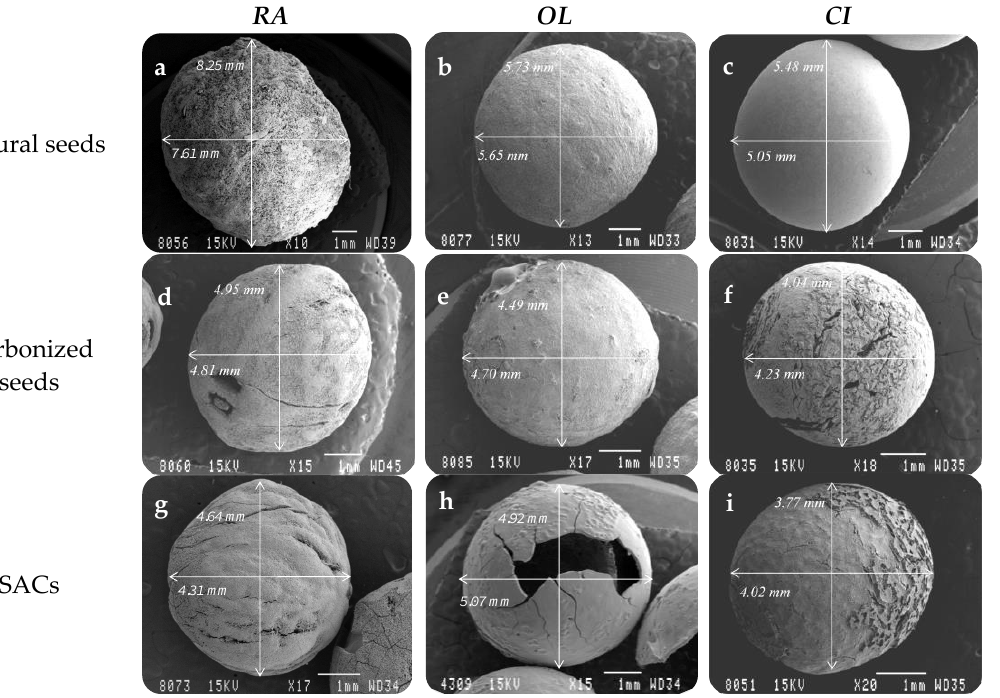
Figure 3. SEM images of precursors, carbonized materials and final SACs. Experimental preparation conditions of the materials: ( a – c ) dried at 110 °C for 3 h; ( d – f ) carbonized at 850 °C for 2 h in 300 mL/min N 2 flow; ( g ) activated at 800 °C for 30 h using 80 mL/min CO 2 flow; ( h ) activated at 800 °C for 2 h in 80 mL/min CO 2 flow; ( i ) activated at 800 °C for 5 h in 80 mL/min CO 2 flow.